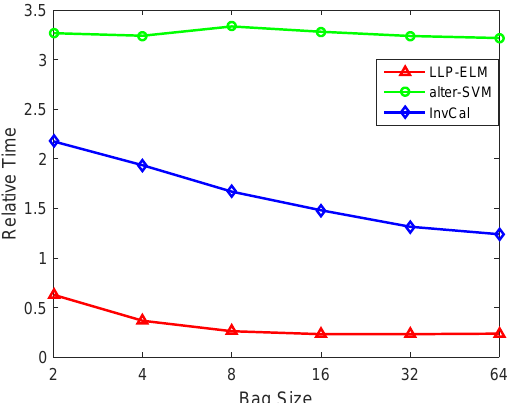
Figure 6. The mean relative time for multi-class datasets of different methods. In detial, the x-axis represents different bag size and y-axis is the relative time.